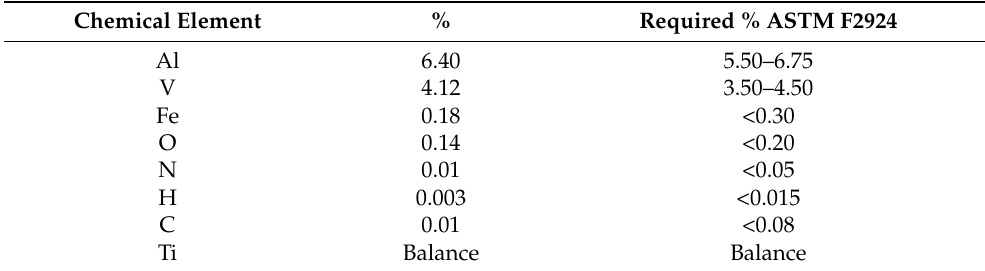
Figure 4. Ti6Al4V powder particle size distribution. Table 2. Nominal chemical composition of the Ti6Al4V pre-alloyed powder.